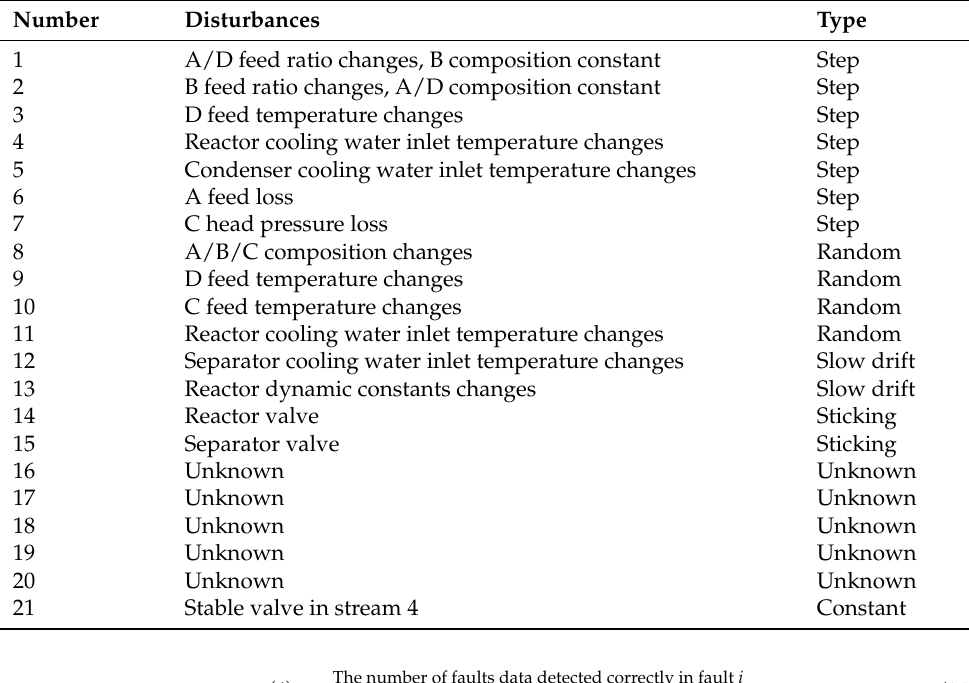
Figure 4. Tennessee Eastman process flowchart. Table 1. Faults in the Tennessee Eastman